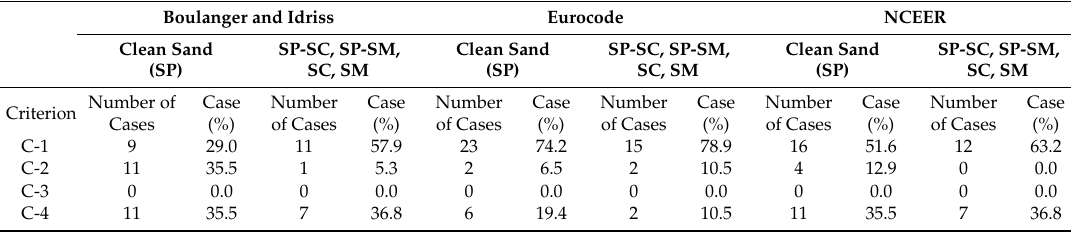
Table 4. Comparative evaluation of factor of safety improvements for SPT-based liquefaction triggering assessment following Boulanger and Idriss, Eurocode, and NCEER methods and specifications after jet grouting by